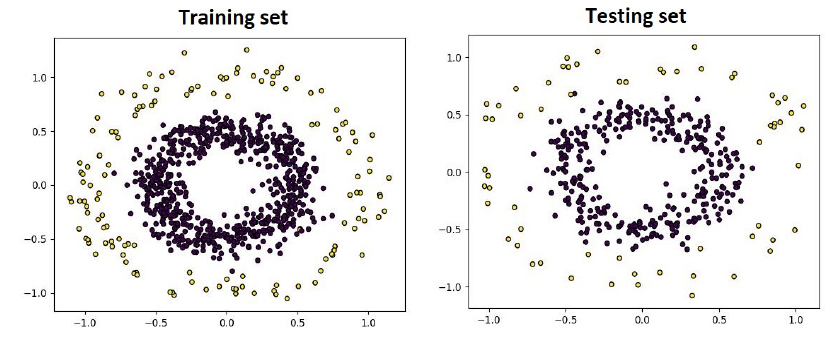
Figure 2. Points from the Circle